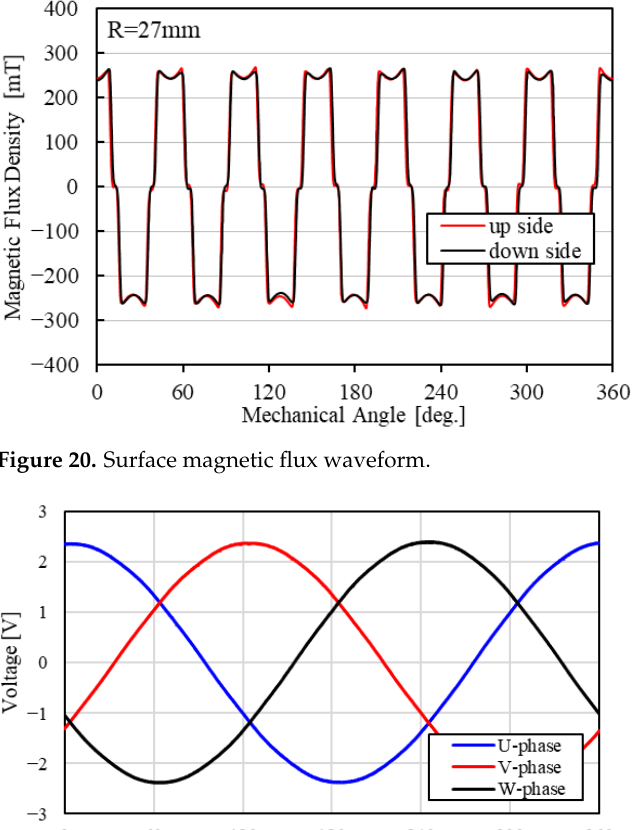
Figure 21. Back e.m.f. waveform at rotating speed of 1000 r/min.